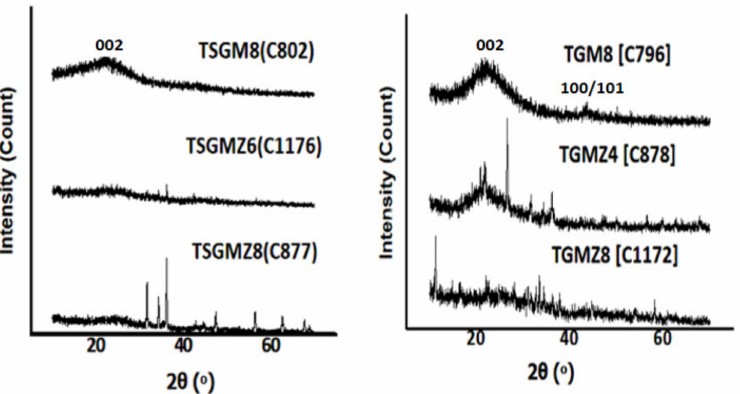
Figure 13. X-ray diffractograms of CNS (without code of Z) and ZnO/CNS composites (with code of Z).